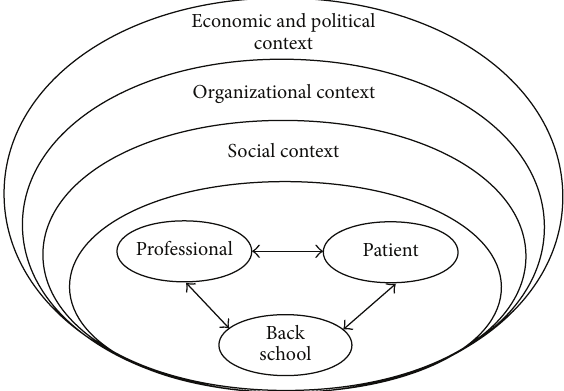
Figure 1: Levels of implementation as reflected in this study, as adapted from Grol and Wensing